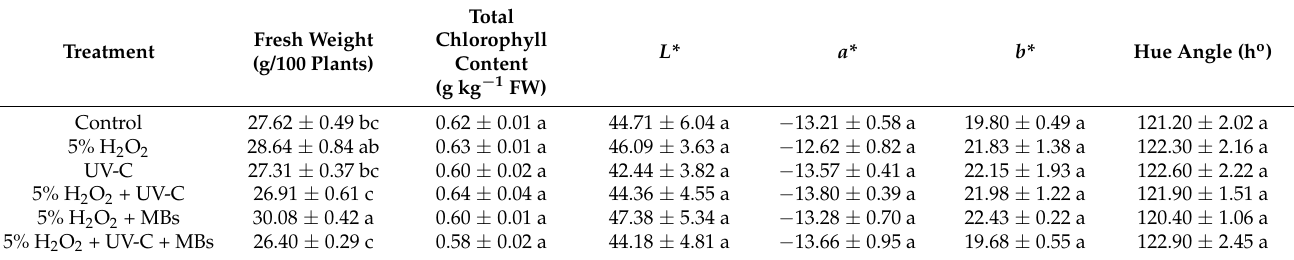
Table 3. Effects of seed decontamination treatments on fresh weight, total chlorophyll content, L* , a* , b* , and hue angle values of their corresponding roselle